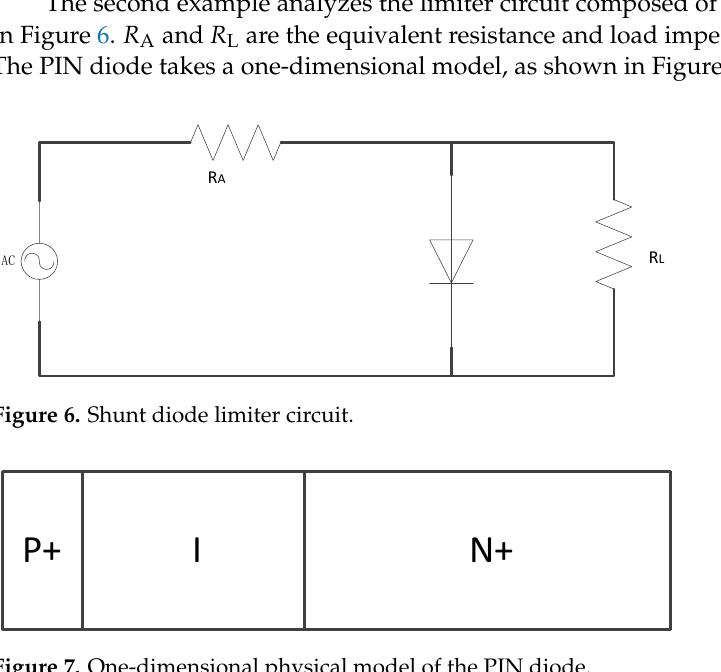
Figure 7. One-dimensional physical model of the PIN diode.